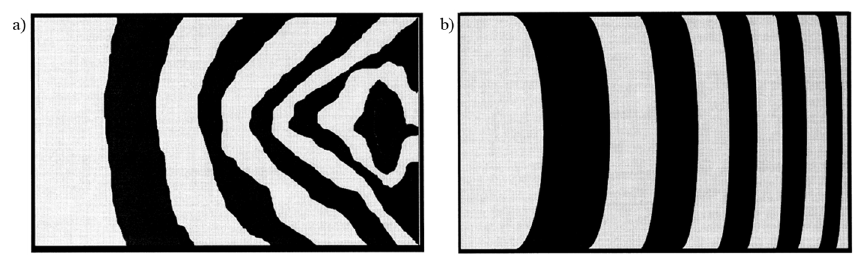
Figure 7. Catalysed phenolic resin flow at elevated temperature (60 °C) in 2-layer random mat hemp reinforcements before ( a ) and after ( b ) fibre washing and edge flow problems were resolved. The flow front is smoother, more uniform, and quasi-1D in ( b ). Flow front isochrones are shown, where each isochrone represents 20 s. The mould filling direction is from left to right. Reproduced from [25], with permission from © 2000 Elsevier.